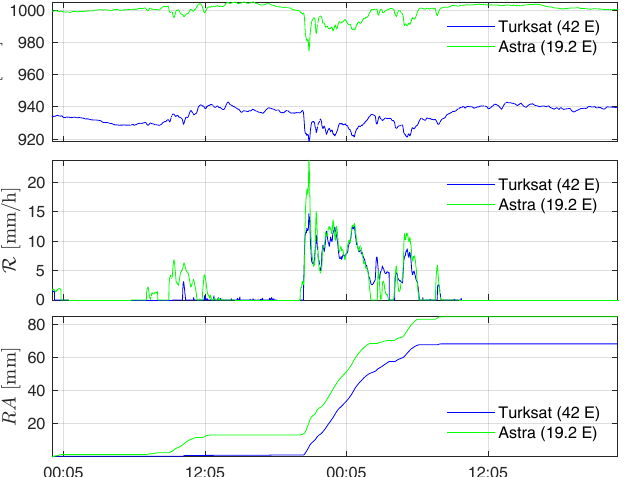
Figure 4. Time series of signal strengths S [ mV ] ( top panel ), rainfall intensity R [mm/h] per minute ( middle panel ), and accumulated rainfall RA [mm] ( bottom panel ) measured by the SRS sensors at the “Pala Eolica” site in the days 4 May and 5 May 2019. Blue line: Turksat 42 E. Green line: Astra 19.2 E.